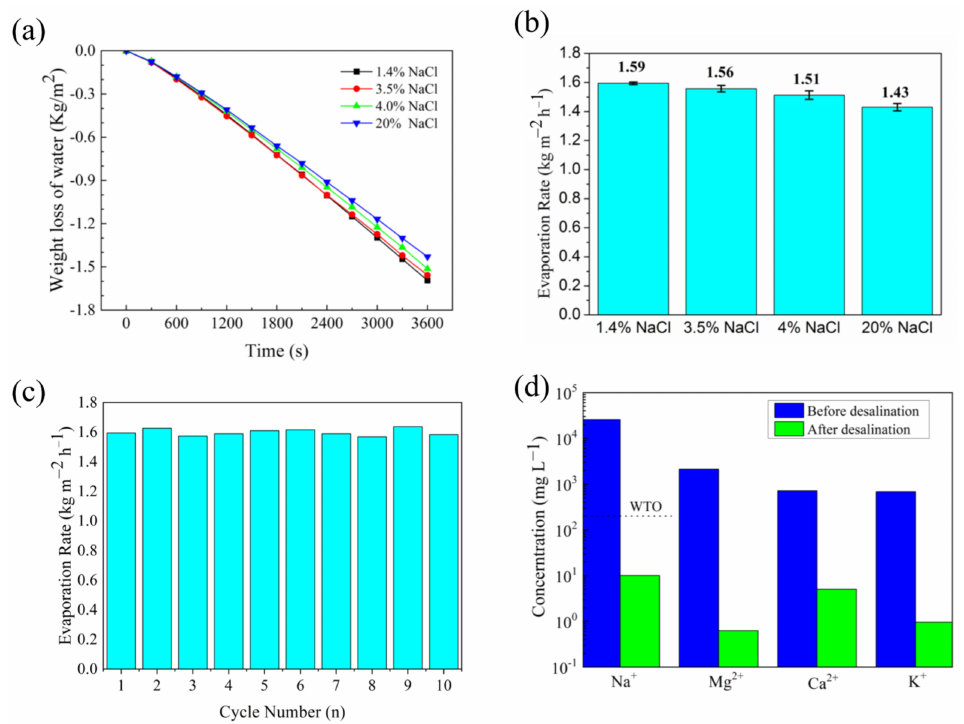
Figure 8. ( a ) Weight loss of water using the CCM when processing NaCl solutions with different salinities; ( b ) the corresponding evaporation rate of the CCM when processing NaCl solutions with different salinities; ( c ) stability test of the evaporation system using the CCM in 3.5 wt% NaCl solution; ( d ) ion concentrations using CCM before and after the solar-driven interfacial